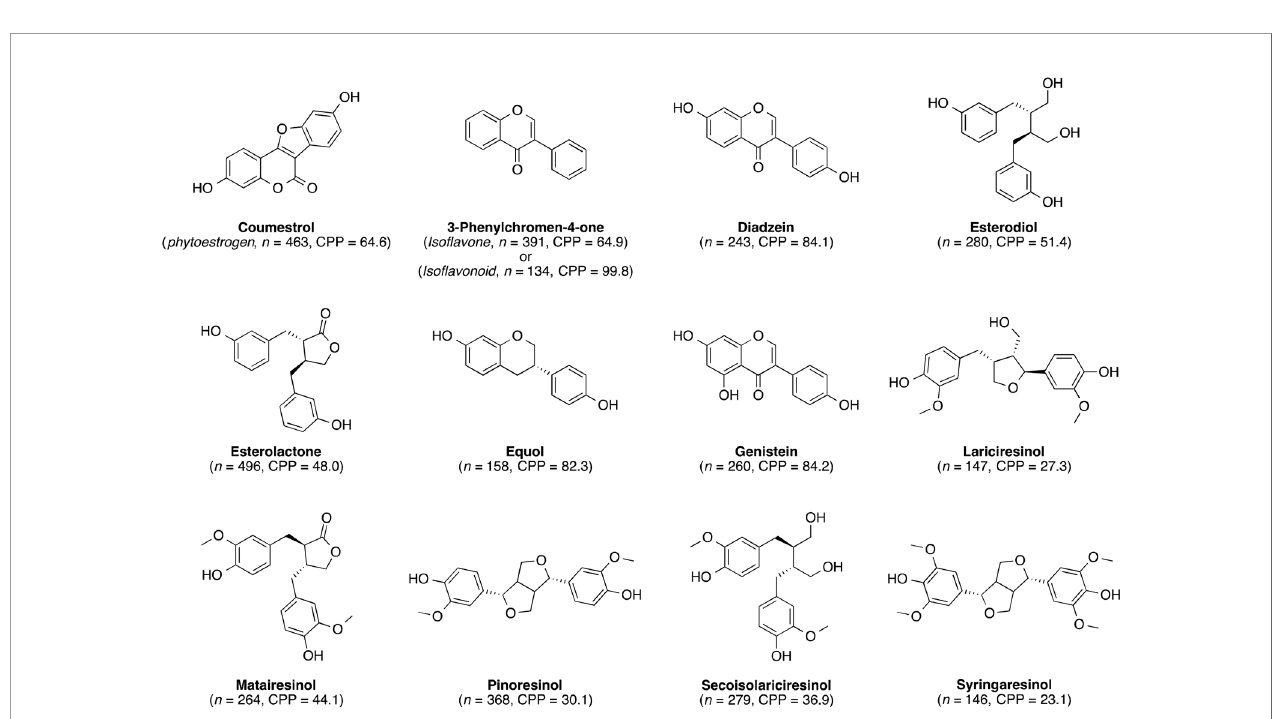
FIGURE 2 | Chemical structures of key single phytochemicals or representatives of chemical classes that were often discussed in the evaluated lignan publications. In parentheses are the cited compound classes ( italic ), number of publications ( n ), and citations per publication (CPP) for each chemical or representative chemical